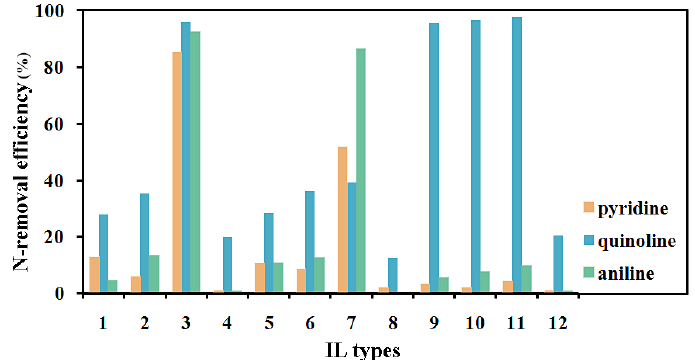
Figure 3. N-removal efficiency of twelve ILs (1: [HHqu][ p -TSA], 2: [HHqu][CH 3 SO 3 ],